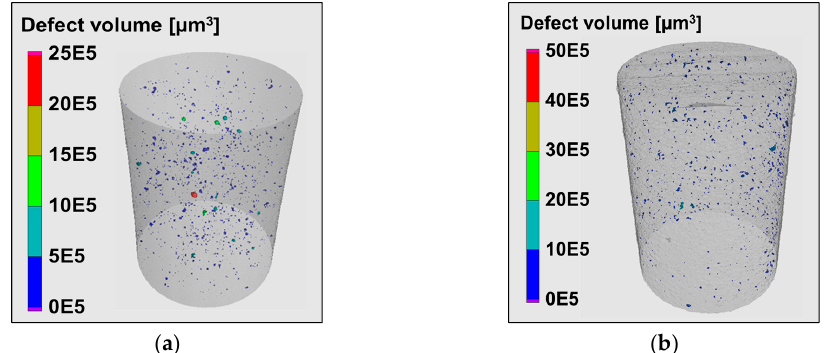
Figure 4. Gauge length scans and 3D defect distributions used in the cyclic deformation simulations: ( a ) AlSi10Mg; ( b ) Ti-6Al-4V.